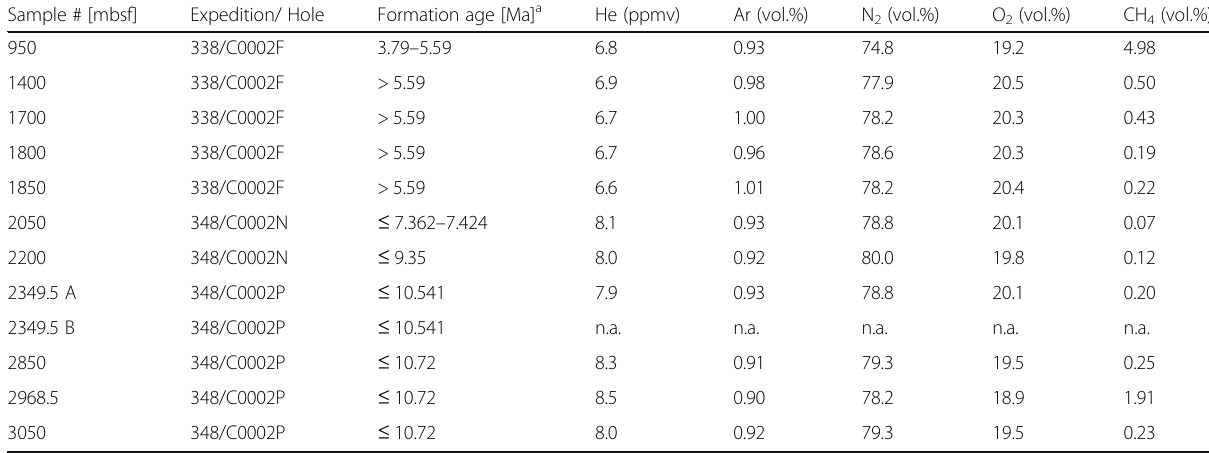
Table 1 Formation ages and the QMS gas composition data from 12 drilling mud gas samples from IODP Expeditions 338 and 348 covering the depth range 950 – 3050 mbsf. Analytical errors are ± 20% for helium and ± 5% for all other gases. Formation ages from nannofossils, C0002F: Strasser et al. 2014c; C0002N/P: Tobin et al.,